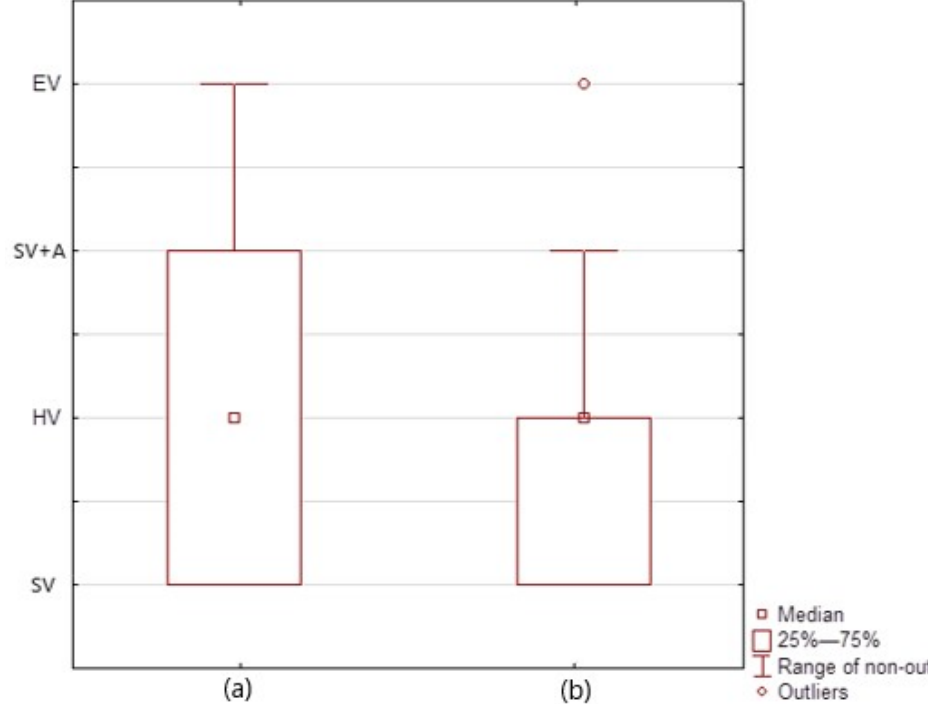
Figure 3. Popularity of car types by source of propulsion in the near future—analysis by the group- ing variable “gender”: ( a ) women; ( b ) men. Abbreviation: electric vehicle (EV), standard vehicle supported by autonomous solutions (SV + A), hybrid vehicle (HV), standard vehicle (SV).